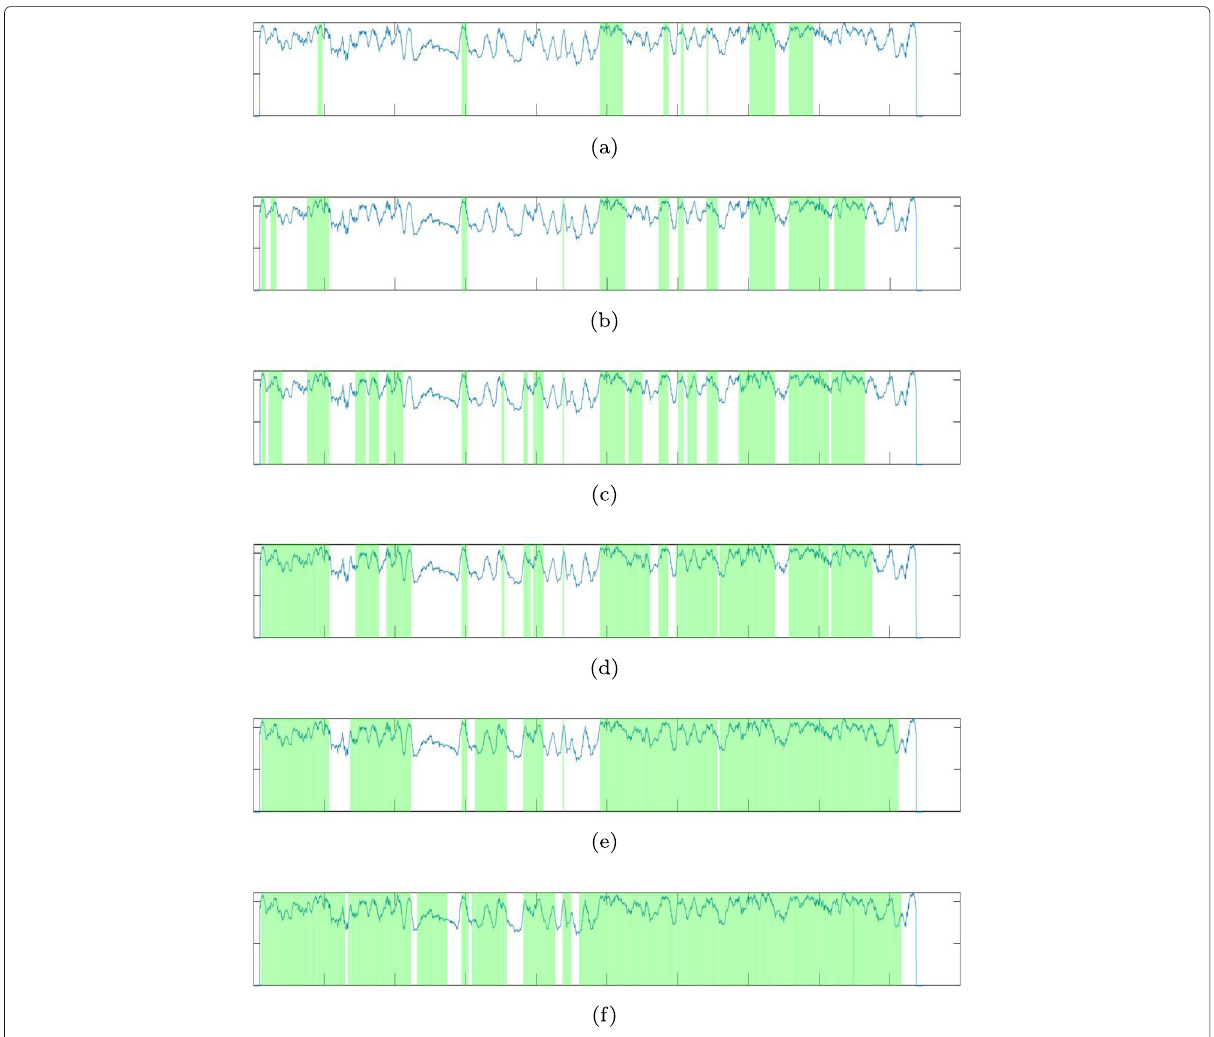
Fig. 4 Results of “Base jumping” from SumMe dataset for different summarization ratios. The selected frames are presented with a green bar at time axis. The energy curves and the selected clips are shown for lengths a 15%, b 30%, c 45%, d 60%, e 75%, and f